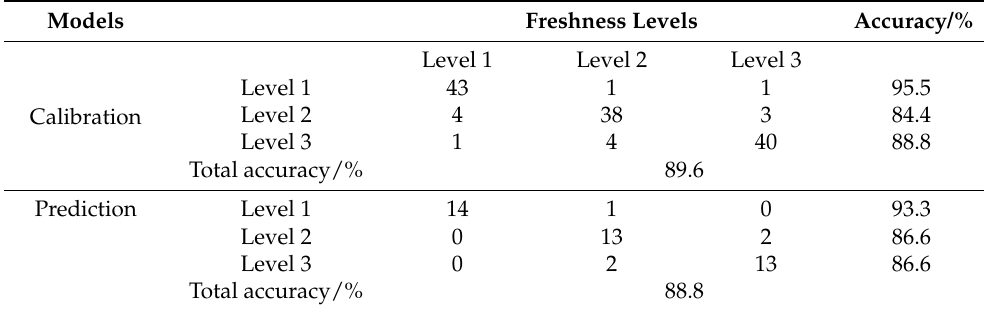
Table 5. Accuracy of classification models of freshness levels in mini-Chinese cabbage by